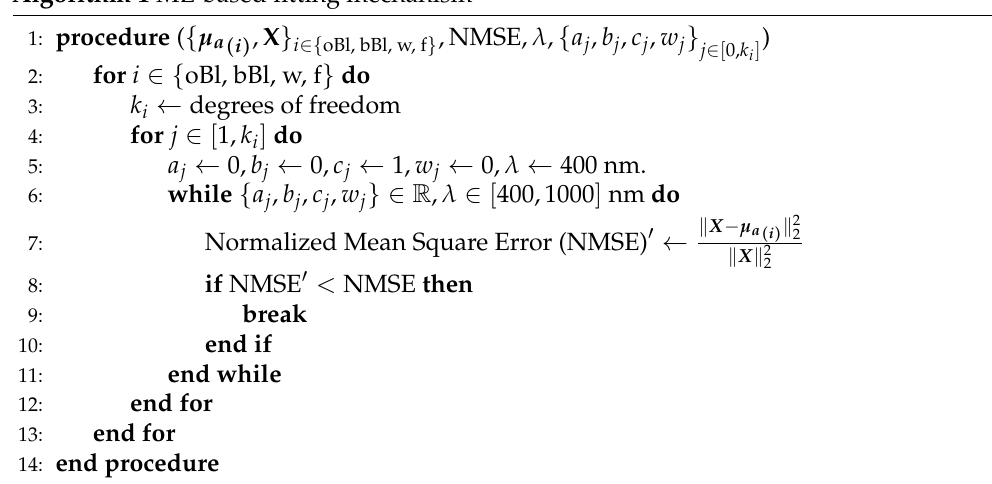
Algorithm 1 ML-based fitting